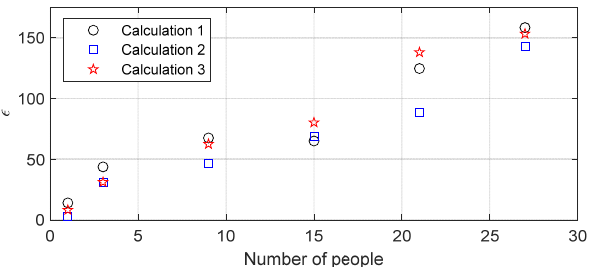
Figure 6. Relation of ε and number of people in a bouncing crowd.